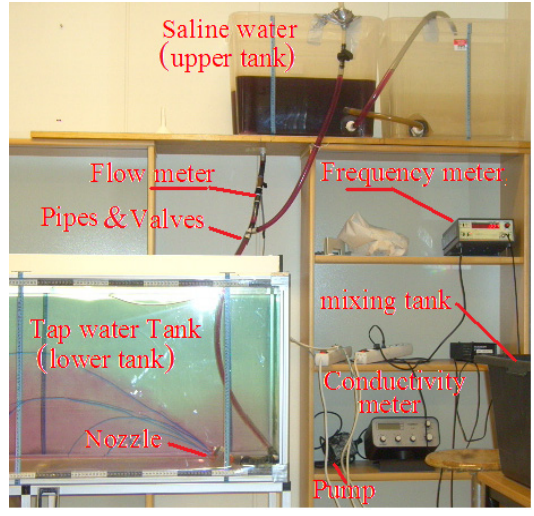
Figure 2. Experimental setup and major